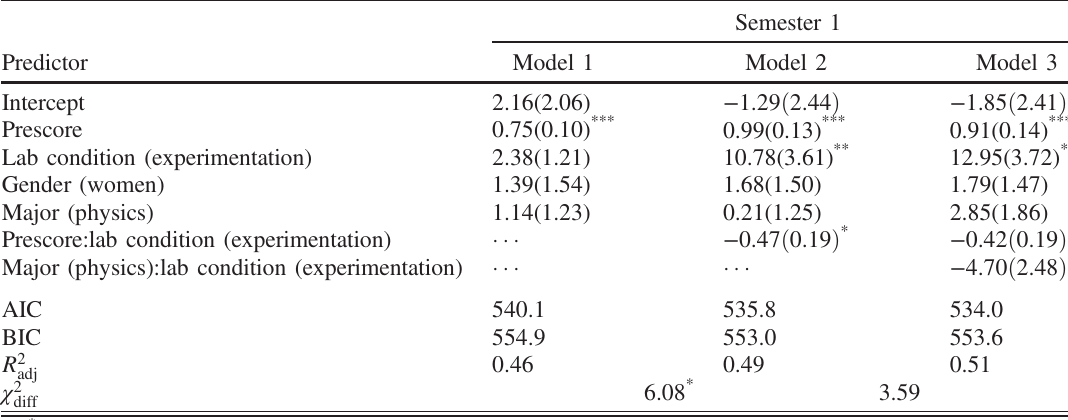
TABLE V. Regression analysis of students ’ postscore on the E-CLASS using the STATS package in R [49]. Models 2 and 3 are statistically equivalent and fit the data better than model 1. There are 86 matched E-CLASS responses included in this analysis. χ 2 is calculated using the lm T est package [52] in R diff